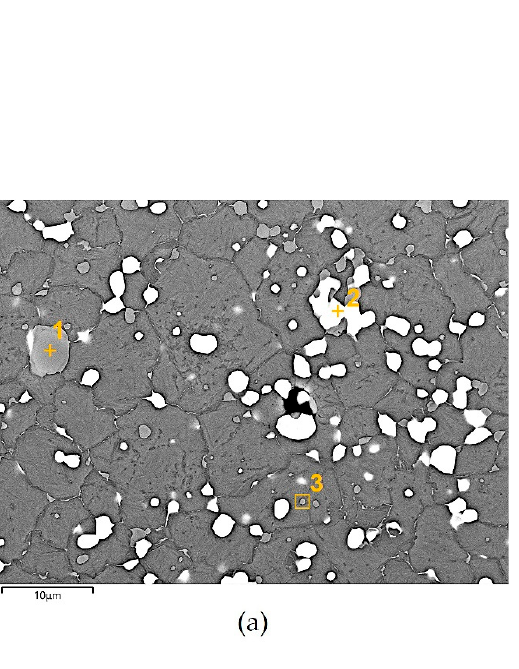
Triple tempering at 560 °C resulted in Vickers hardness of 892 HV1, corresponding to 66 HRC.